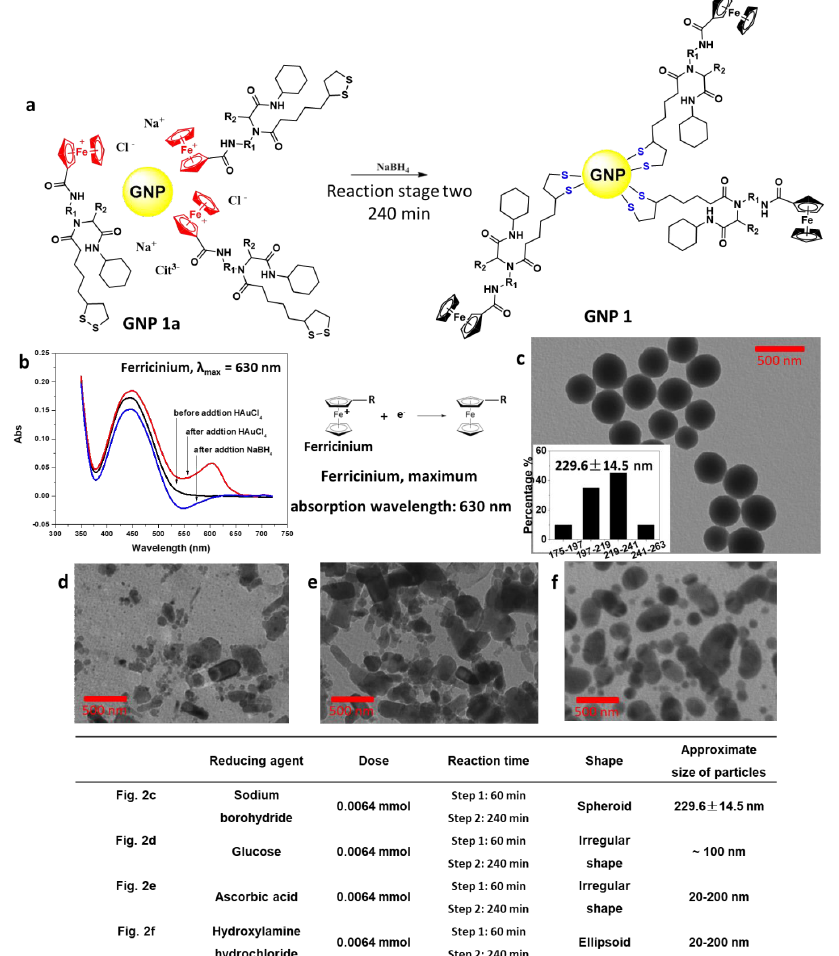
Figure 2. Reduction of ferricinium and formation of Au-S bond using NaBH 4 in stage two. ( a ) Reaction scheme for stage two. ( b ) UV–Vis spectrum of supernatant (λ max = 630 nm) showed that ferricinium intermediates appeared in 630 nm. ( c ) TEM images of the 200 nm GNPs. ( d ) Using glucose (0.0064 mmol) instead of NaBH 4 . ( e ) Using ascorbic acid (0.0064 mmol) instead of NaBH 4 . ( f ) Using hydroxylamine hydrochloride (0.0064 mmol) instead of NaBH 4 .